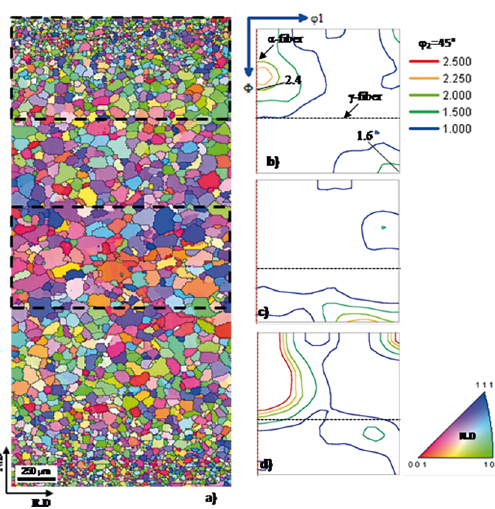
Figure 1. Microstructure and texture of annealed hot-rolled sample – a) orientation map. b) Global texture, ϕ =45° ODF sections. c) Texture 2 of the region near the surface. d) Texture of the central region.